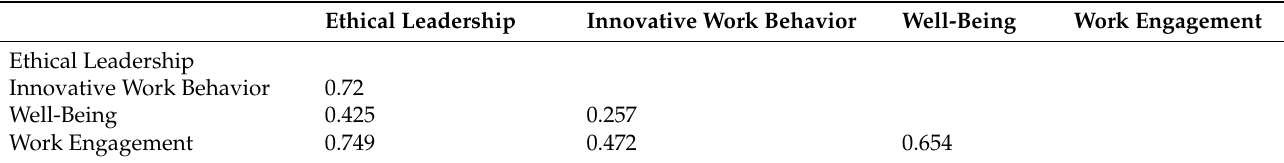
Table 3. HTMT Ratios.